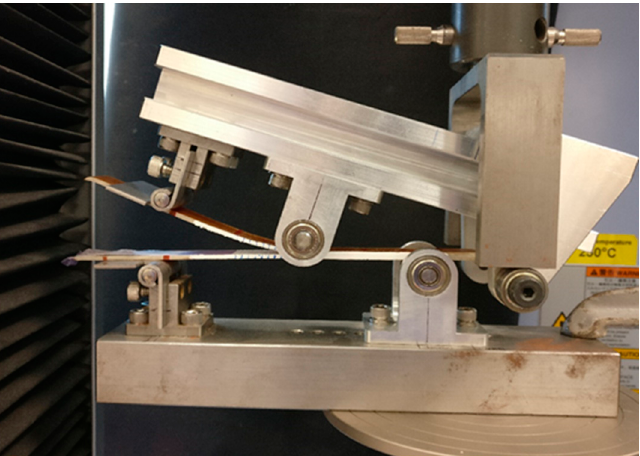
Figure 8. MMB specimen under test.